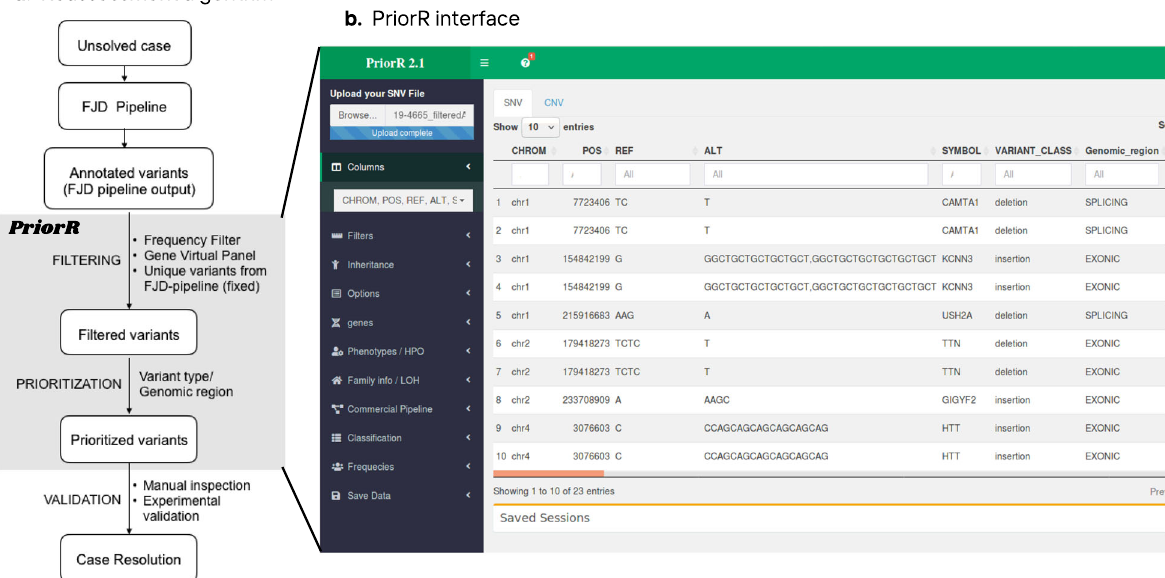
Fig. 4 Reanalysis algorithm in PriorR. a Describes the algorithm followed in the reassessment of the selected negative cases from the general cohort. The output of the FJD-pipeline is read and analyzed in PrioR where variant fi ltering and prioritization is carried out; this process is followed by a validation in case of candidate variants. b PriorR interfaces for SNV